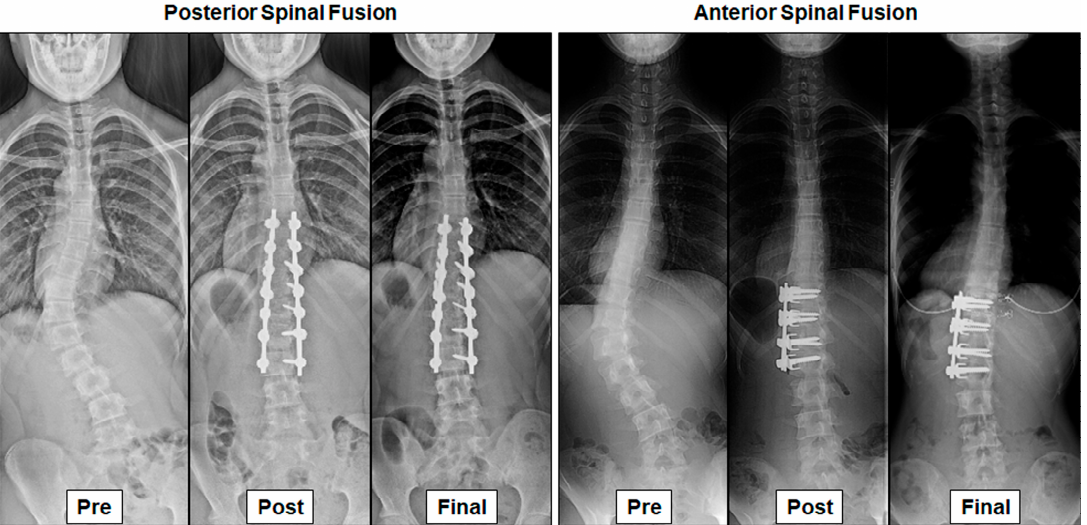
Figure 1. Radiographs of posterior and anterior spinal fusion for thoracolumbar adolescent idio- pathic scoliosis at preoperative, postoperative, and final follow-up. scoliosis at preoperative, postoperative, and final